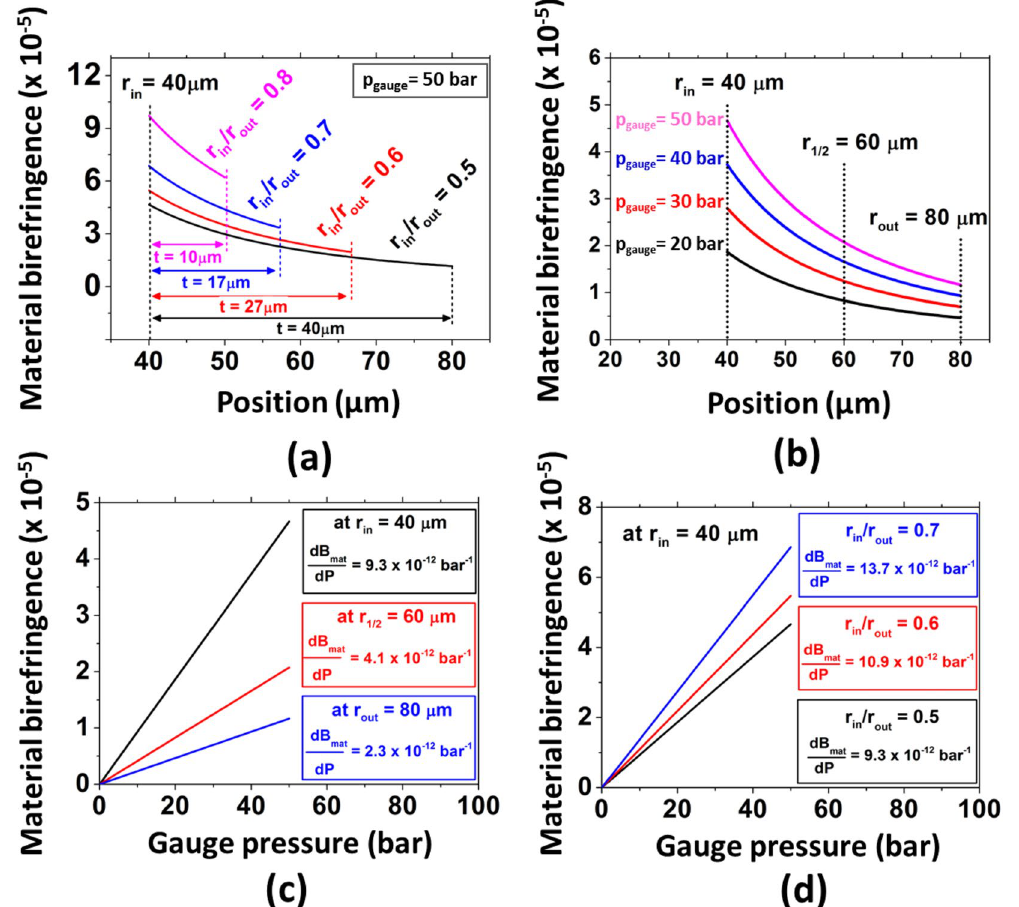
Figure 3. Study of pressure-induced material birefringence. ( a ) Material birefringence along the horizontal axis for capillaries with different r in /r out ratios and ( b ) for a capillary with r in = 40 μ m and r out = 80 μ m under increasing gauge pressure values. ( c ) Material birefringence as a function of gauge pressure at the positions r in = 40 μ m, r 1/2 = 60 μ m, r out = 80 μ m and ( d ) for a capillary with r in = 40 μ m and a r in /r out ratio equal to 0.5, 0.6 and